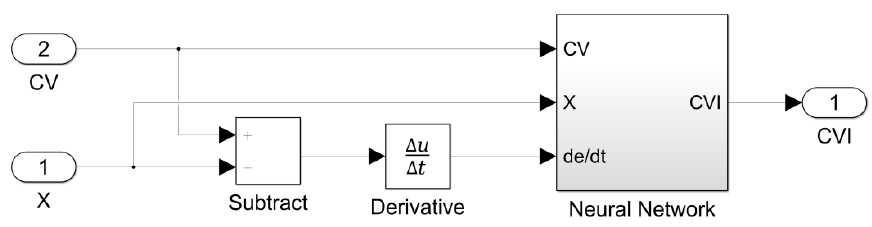
Figure 12. The simplified block schematics of the Simulink model of the neural PD controller.